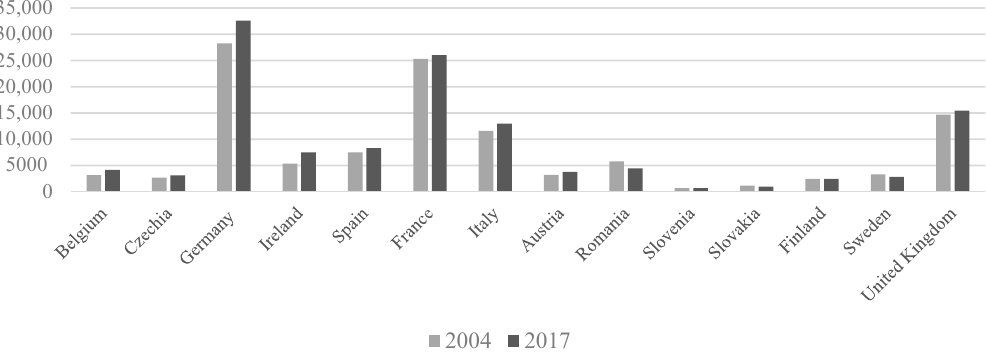
Figure 3. Development of raw milk production (1000 t) in selected countries. Source: Eurostat.